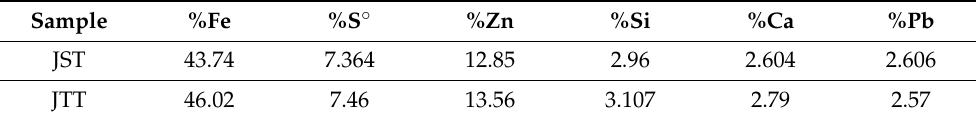
Table 1. Chemical composition (%) of the JTT sample.